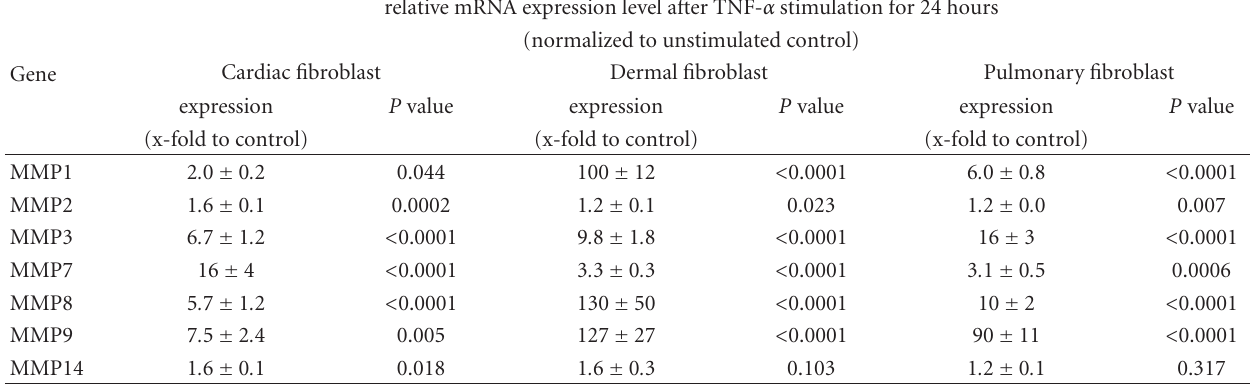
Table 2: Relative mRNA expression level of di ff erent MMPs in cardiac, dermal, and pulmonary human fibroblasts after treatment with 10ng/mL TNF- α for 24 hours. The mRNA expression was normalized to the housekeeping gene CDKN1b and to the according untreated control using the formula 2 − ΔΔ Ct and is given as x-fold increase. For statistical significance treated and untreated control were compared using Mann-Whitney U